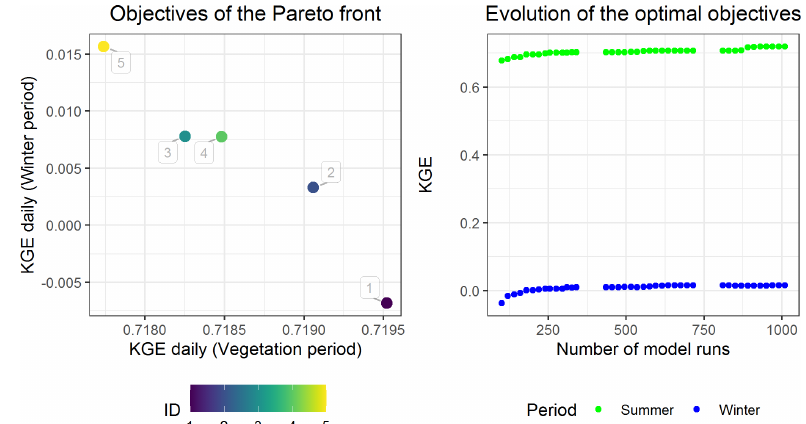
Figure C5. Resulted calibration Pareto fronts for Oberbärenburg (chosen ID – 5).